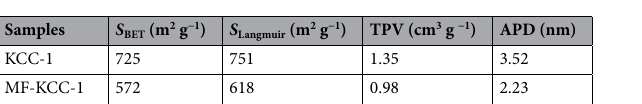
Table 1. Textural properties of KCC-1 and MF-KCC-1.